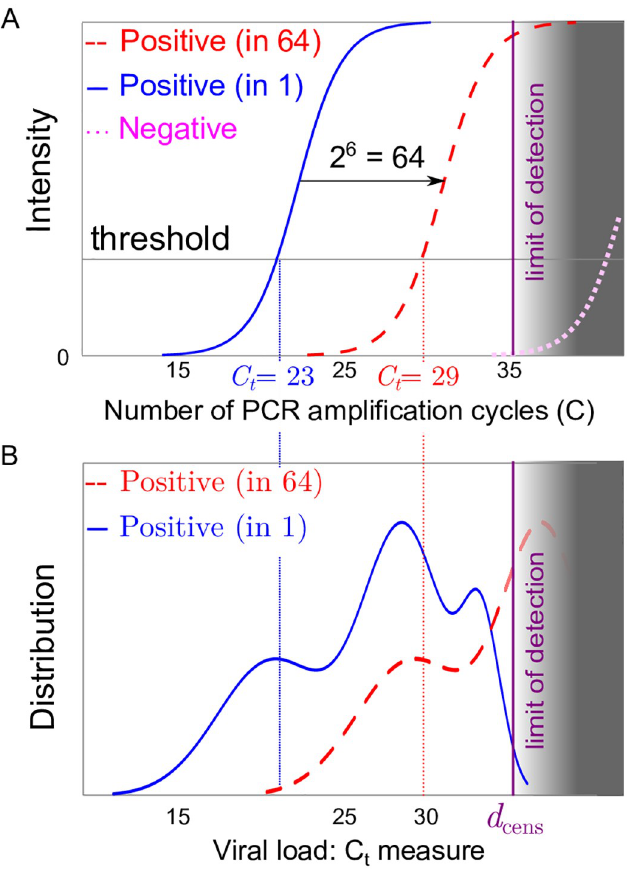
Fig 1. (A) Sketch of an RT-qPCR fluorescence intensity signal for a positive patient without pooling (solid red line) a single positive patient in a pool of 64 patients (dashed red curve) and for a negative sample representing the response of an artefact (dotted magenta curve); as pooling dilutes the initial concentration, the pooled response (dashed red curve) is expected to be close to the translation x ! x + 6 from that of a single patient (solid red line). (B) Sketch of the distribution of threshold values for RT-qPCR individual tests (solid blue line) or in pools 64 (dashed red curve); part of the distribution crosses the limit of detection of the test (figured as the grey area) at the detection threshold d cens .